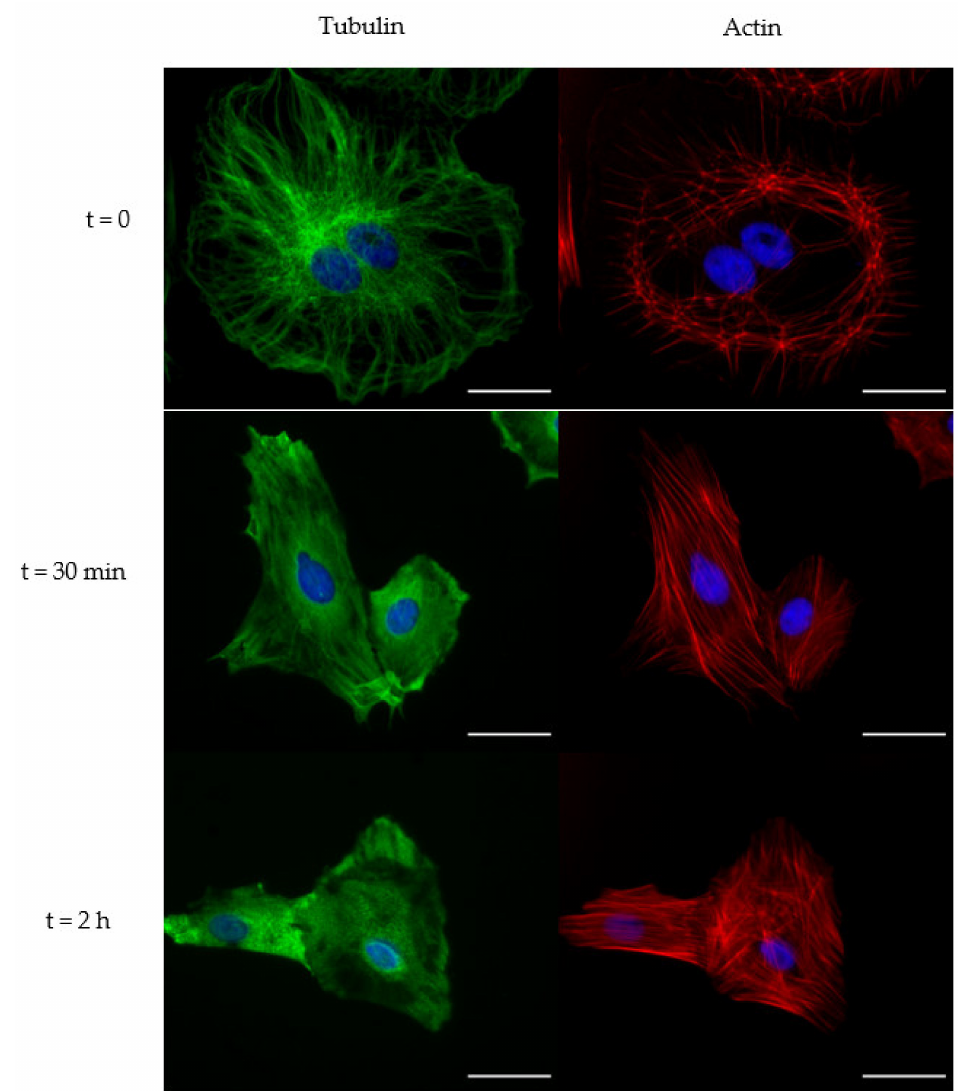
Figure 6. Effect of 10 µ M Noc treatment on cytoskeletal tubulin and actin. Fluorescent images for control (t = 0) and cells after 30 min (t = 30 min) and 2 h (t = 2 h) of treatment. Scale bar: 40 µ